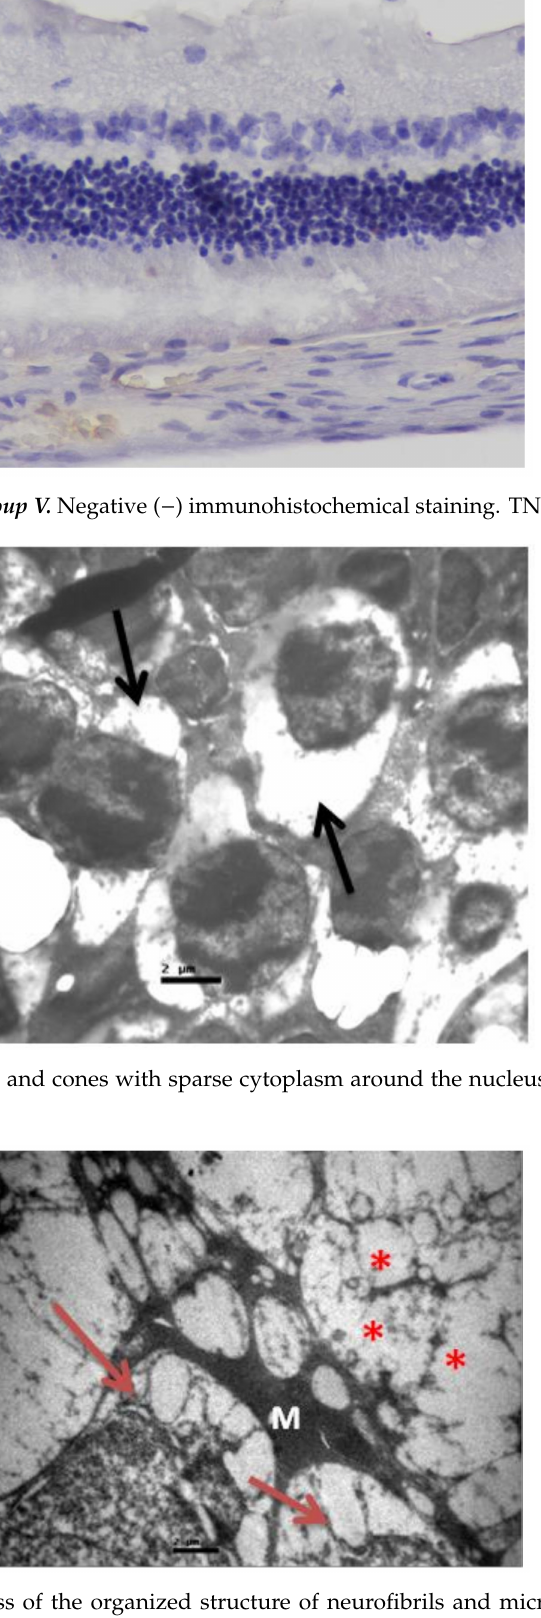
Figure 10. Group V. Loss of the organized structure of neurofibrils and microtubules. (*) Müller cell.(M)Ganglion cells with vacuolization and dilatation of the rough endoplasmic reticulum. ( ↑